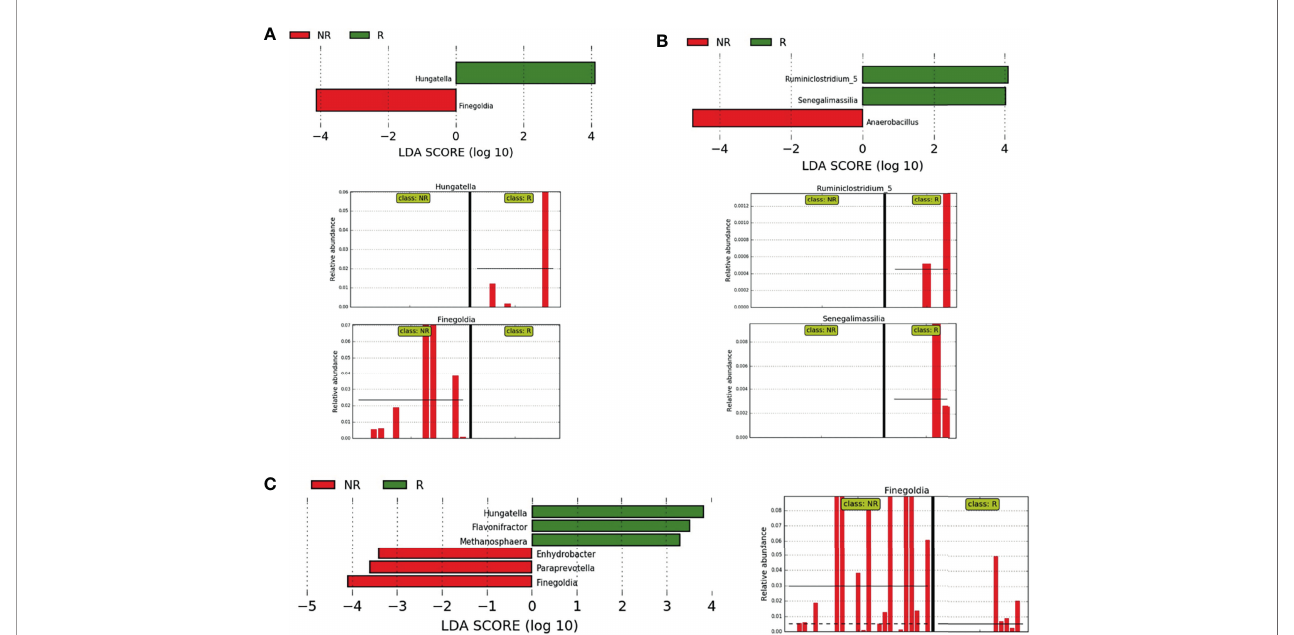
FIGURE 6 | Differently abundant bacteria between R and NR. (A, B) LEfSe at the genus level for pre-treatment LARC biopsies according to the country of origin and response to neoadjuvant treatment. NR samples are indicated by red and R samples by green; horizontal bars represent the effect size for each genus and bar length represents the log10 LDA score, indicated by the dotted lines (vertical). (A) BR R and NR patients, the two plots in the bottom highlights genera present exclusively in NR and R samples; (B) AR R and NR patients, the two plots in the bottom highlight genera present exclusively in R samples. (C) LEfSe at the genus level for pre-treatment LARC biopsies from Argentina and Brazil according to the response to neoadjuvant treatment. NR samples are indicated by red and R samples by green; horizontal bars represent the effect size for each genus and bar length represents the log10 LDA score, indicated by the dotted lines (vertical). The plot in the bottom highlights the genus Finegoldia present almost exclusively in NR